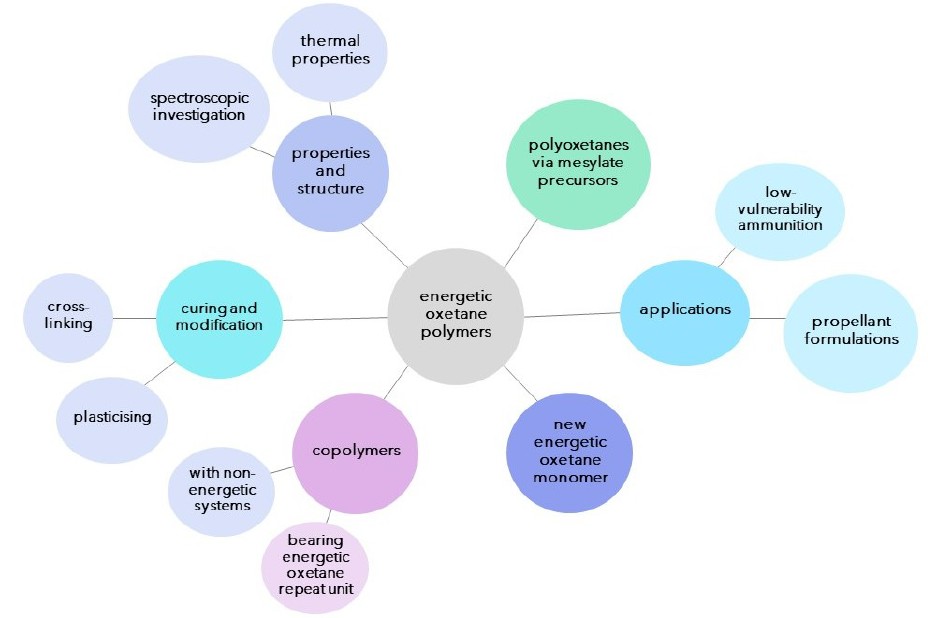
Figure 2. Schematic diagram covering the overall review